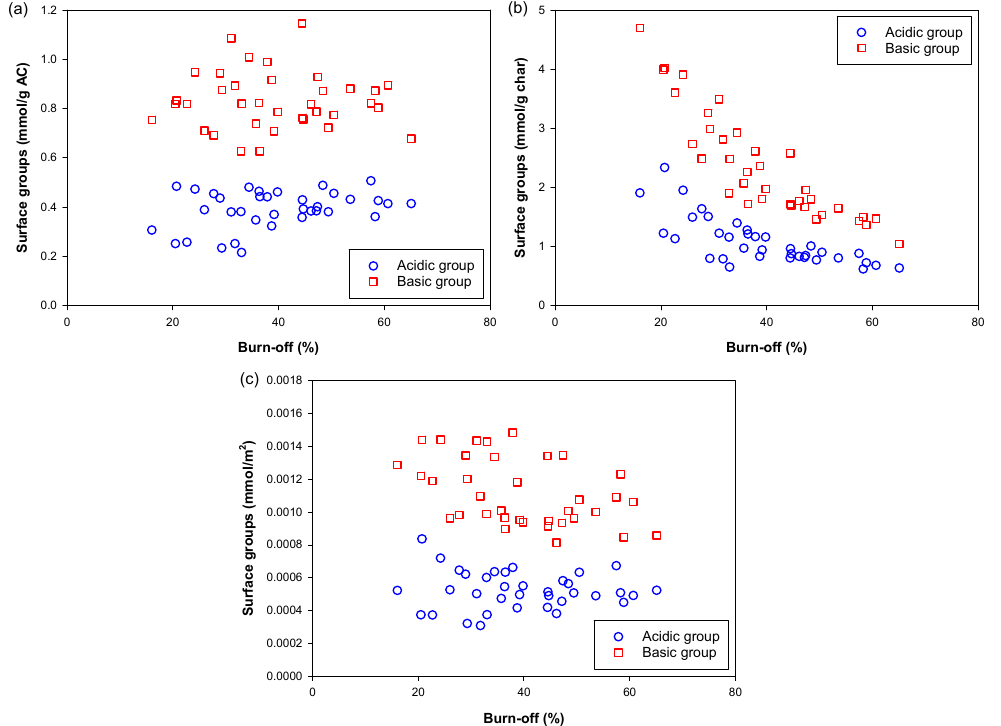
Figure 17. Presentation of surface group concentration in three different units of ( a ) mmol/g carbon, ( b ) mmol/g char and ( c ) mmol/m 2 of BET surface area, as a function of percentage of char burn - off .